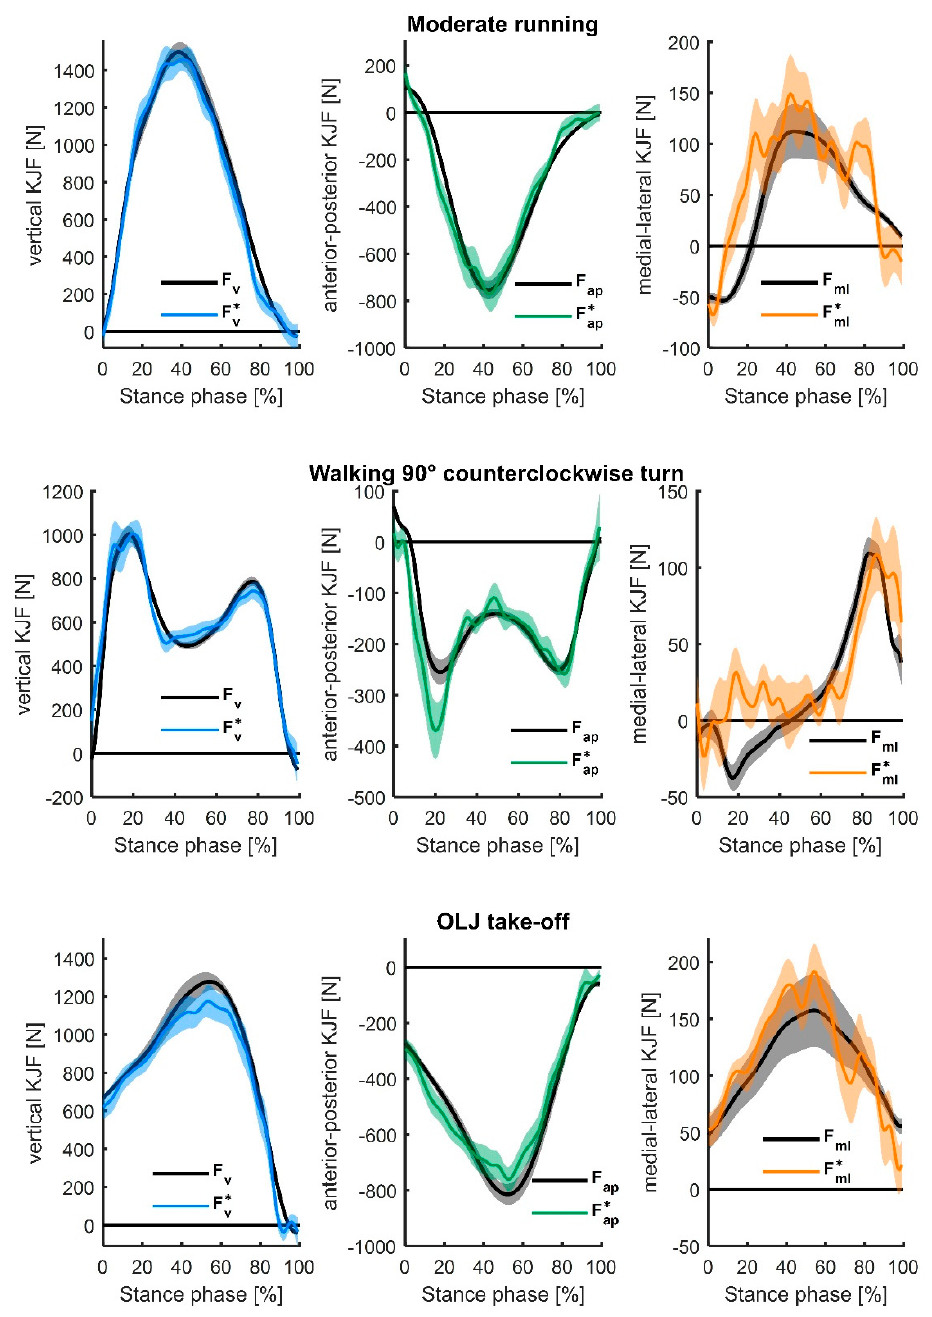
Figure 2. Mean (and standard error) of the estimated three-dimensional (3D) knee joint forces (KJF) ( F ∗ v , F ∗ ap , and F ∗ ) for moderate running (top), walking a 90 ◦ counterclockwise turn (middle), and one-leg horizontal jump (OLJ) take-off are presented (normalized to the stance phase), compared to their respective reference values (inverse dynamics-calculated knee joint forces F v , F ap , and F ml ).